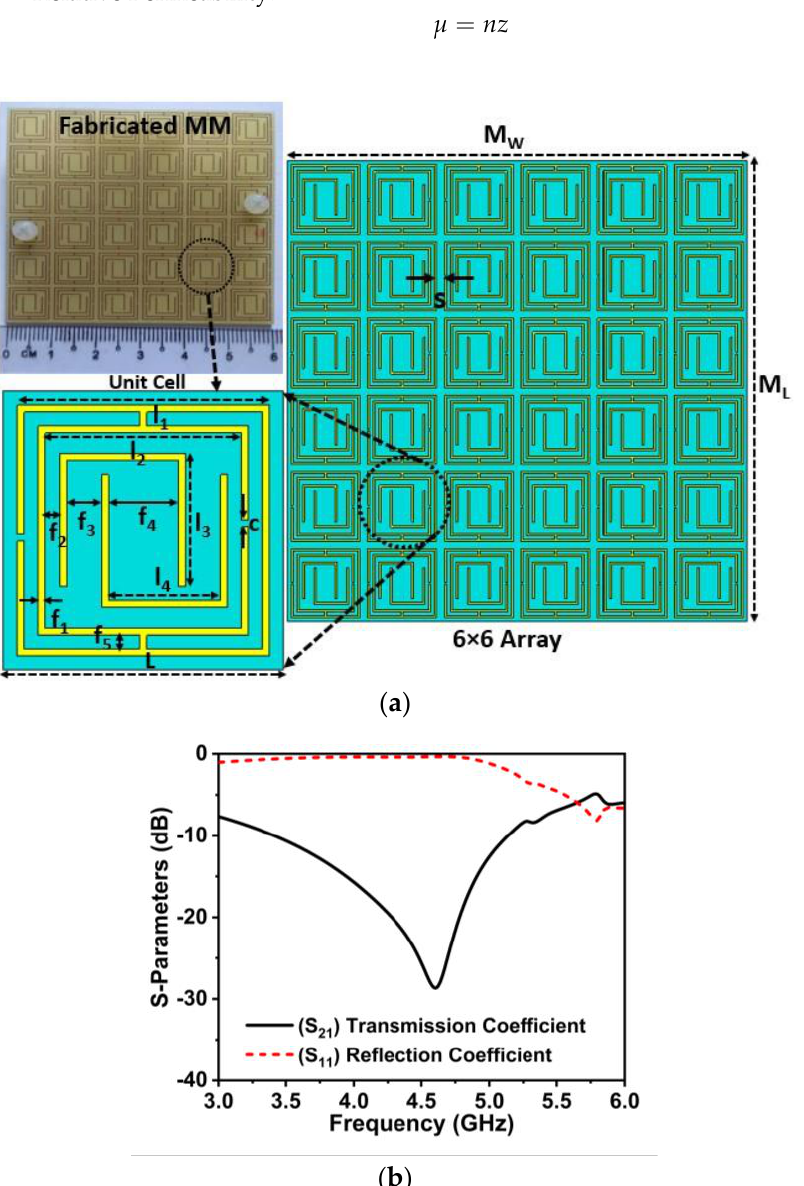
Figure 1. ( a ) MM design details with its fabricated prototype ( L = 10, I 1 = 9, I 2 = 7.5, I 3 = 4.75, I 4 = 4.5, f 1 = 0.25, f 2 = 0.5, f 3 = 1.25, f 4 = 2, f 5 = 0.5, s = 1.0 and c = 0.25, unit: mm) and ( b ) transmission and reflection coefficients curve.